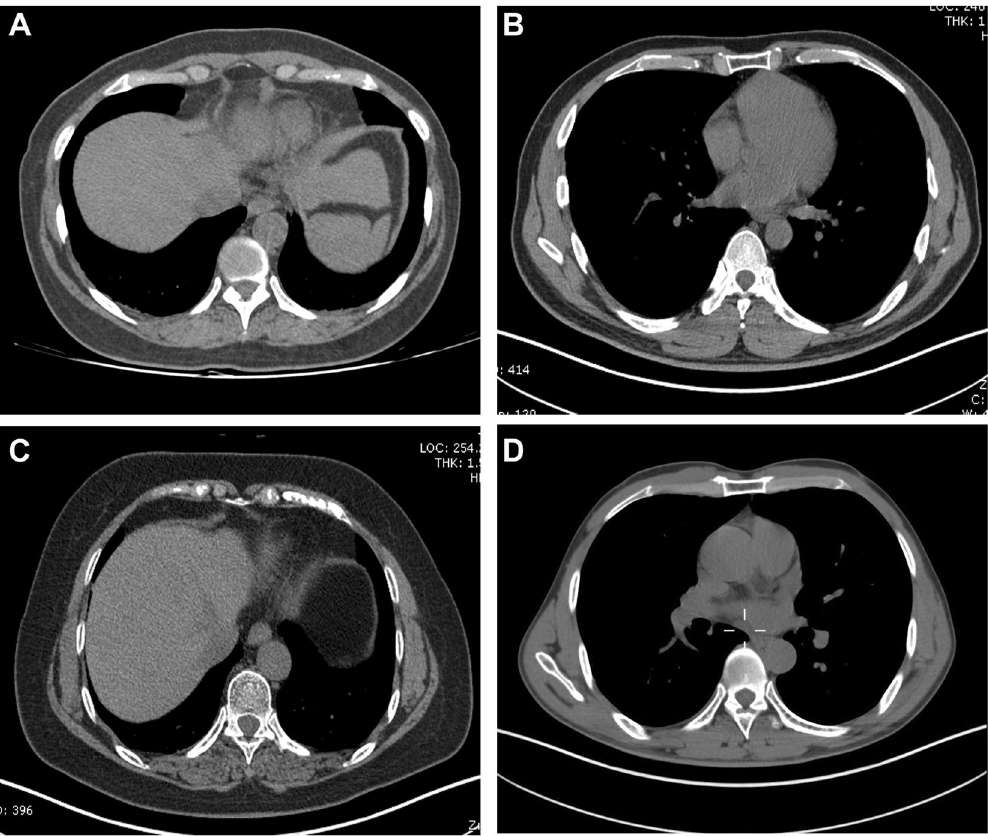
Figure 7. Calcification patterns of costal cartilage. Calcification patterns of costal cartilage were divided into the following types: ( A ) central, ( B ) peripheral, ( C ) mixed and ( D ) no